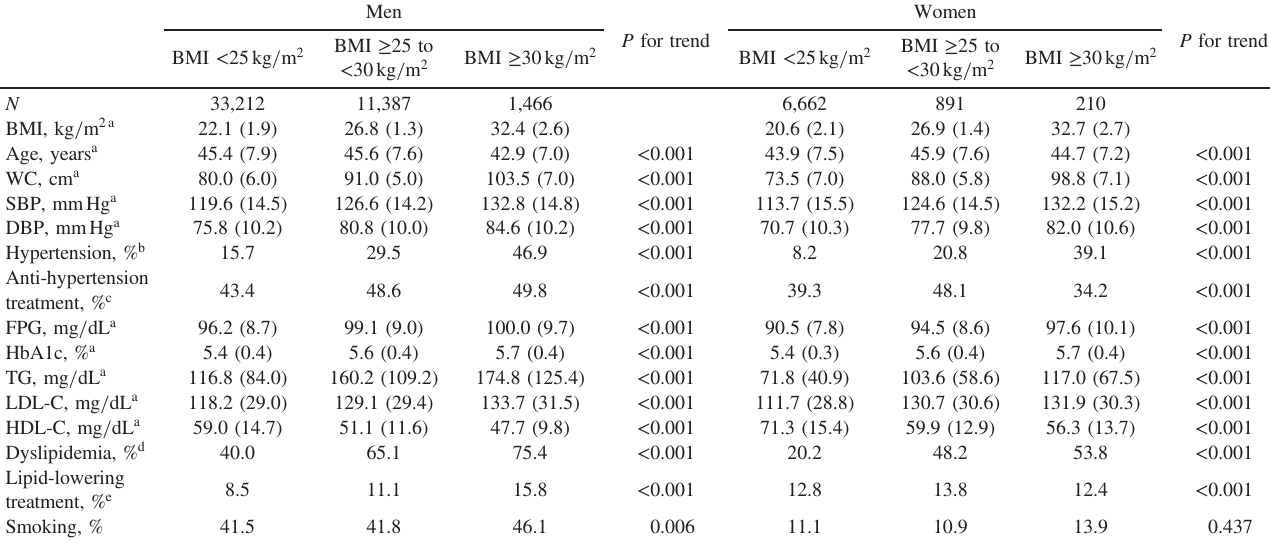
Table 1. Baseline characteristics by sex and baseline BMI